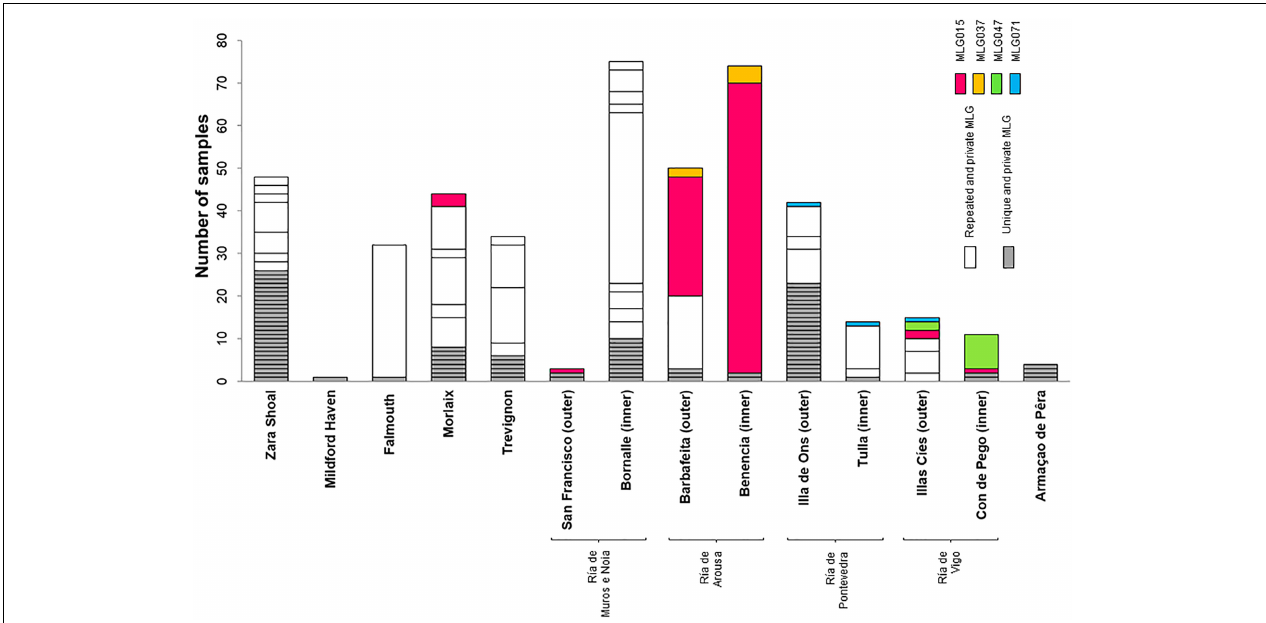
FIGURE 3 | MultiLocus Genotypes (MLGs) observed for eight microsatellite markers in Phymatolithon calcareum from fourteen study sites. Private and unique MLGs are shown in gray while private repeated MLGs and are shown in white. The different colors represent MLGs shared between